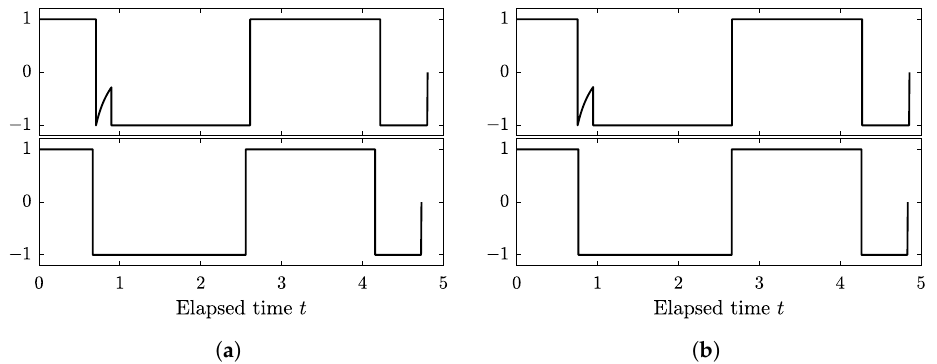
Figure 6. Optimal control structure with non-zero initial velocities: ( a ) ˙ y ( 0 ) = 0.1 (top) and ˙ y ( 0 ) = 0.2 (bottom), and ( b ) ˙ θ ( 0 ) = 0.1 (top) and ˙ θ ( 0 ) = 0.2